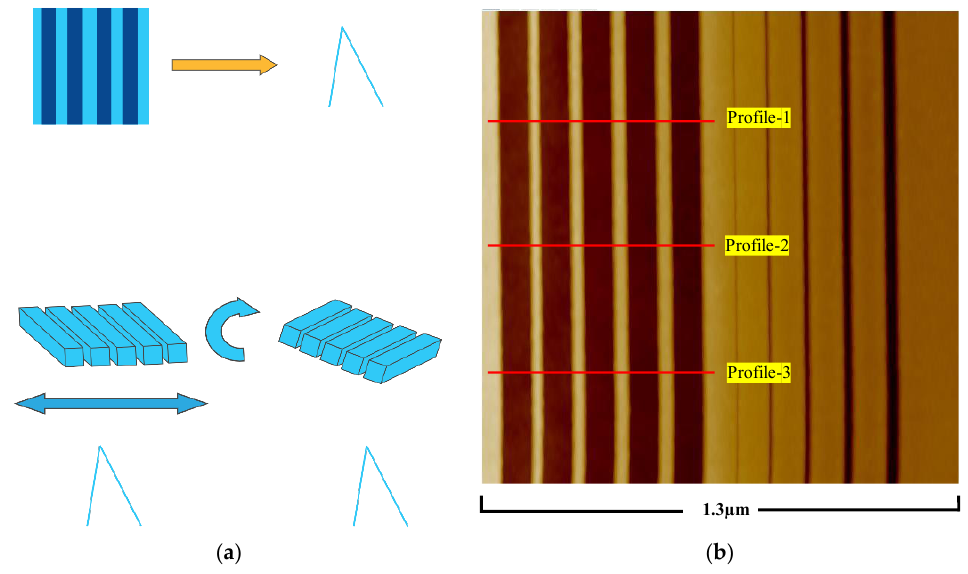
Figure 7. ( a ) Scanning process of tip characterizer with a commercial probe; ( b ) Typical AFM scan results of the tip characterizer.